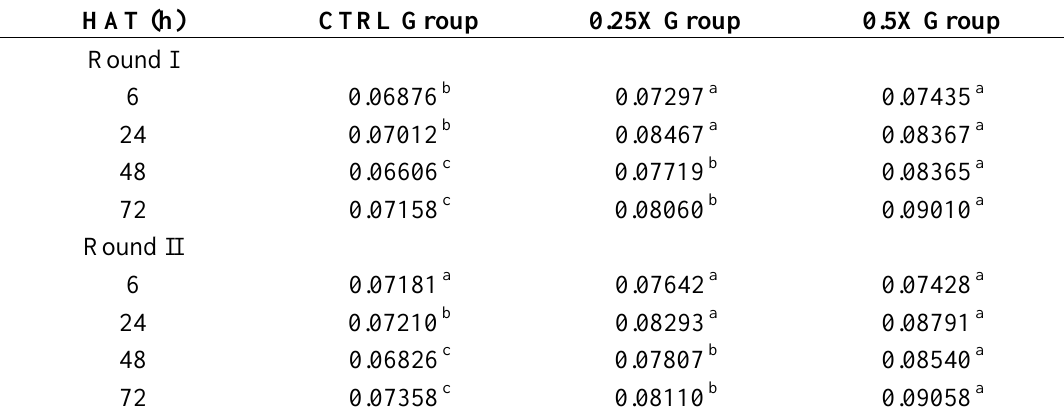
Table 9. Cross validation results for FCA based on Duncan’s multiple range tests * . Each c value is a mean of three cotton leaves for the same group in the validation dataset.